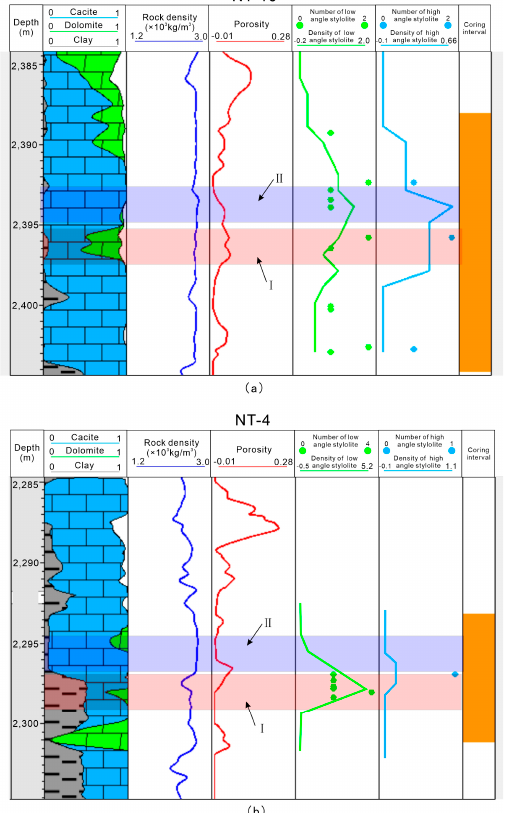
Figure 10. The intensity of stylolites in well intervals with different rock composition. ( a ) The in ‐ terval with different rock composition of well NT ‐ 10. ( b ) The interval with different rock composi ‐ tion of well NT ‐